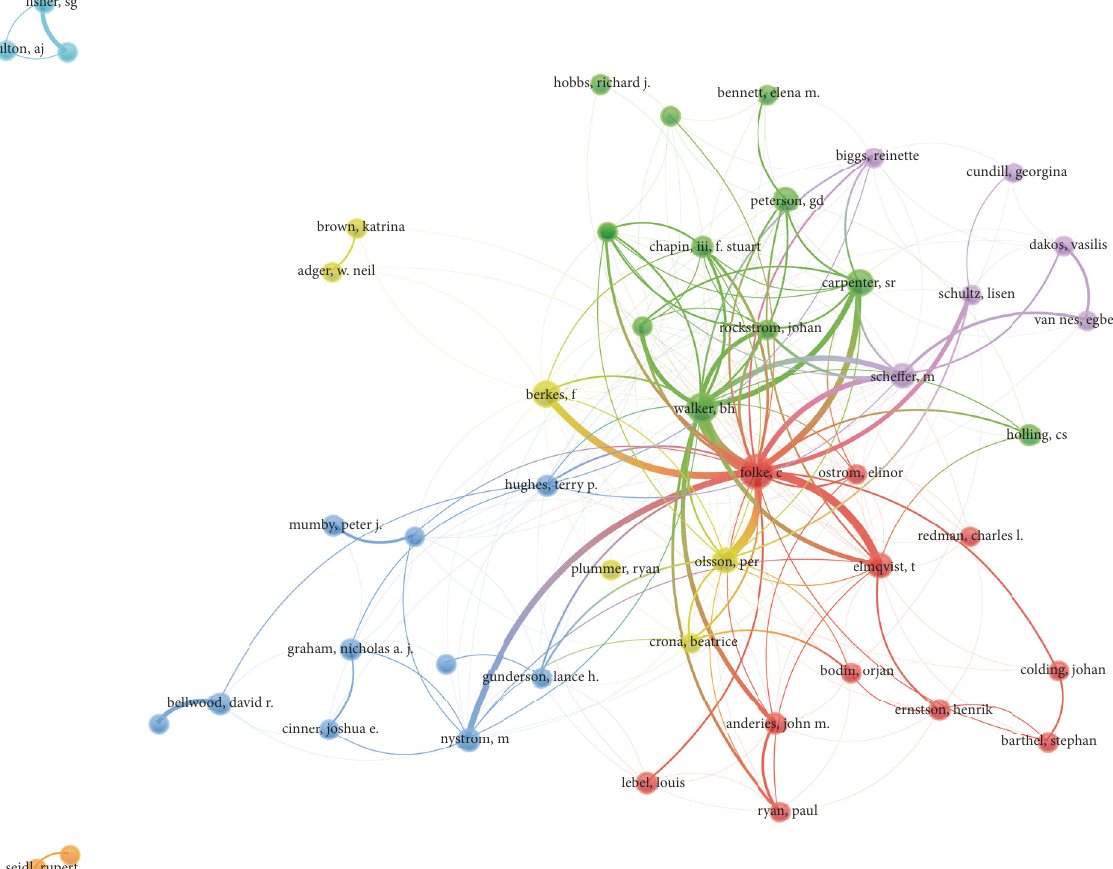
Figure 1: Updated author collaboration network for Environmental Science and Ecology. Collaboration network of those authors with 5 or more papers in the 1000 most cited papers using the topic search (resilience AND ((complex NEAR/2 system ∗ ) OR “social-ecological system ∗ ” OR community ∗ OR organisation ∗ or ecosystem ∗ )), filtered by subjects “environmental science” and “ecology.” Colours represent clusters of